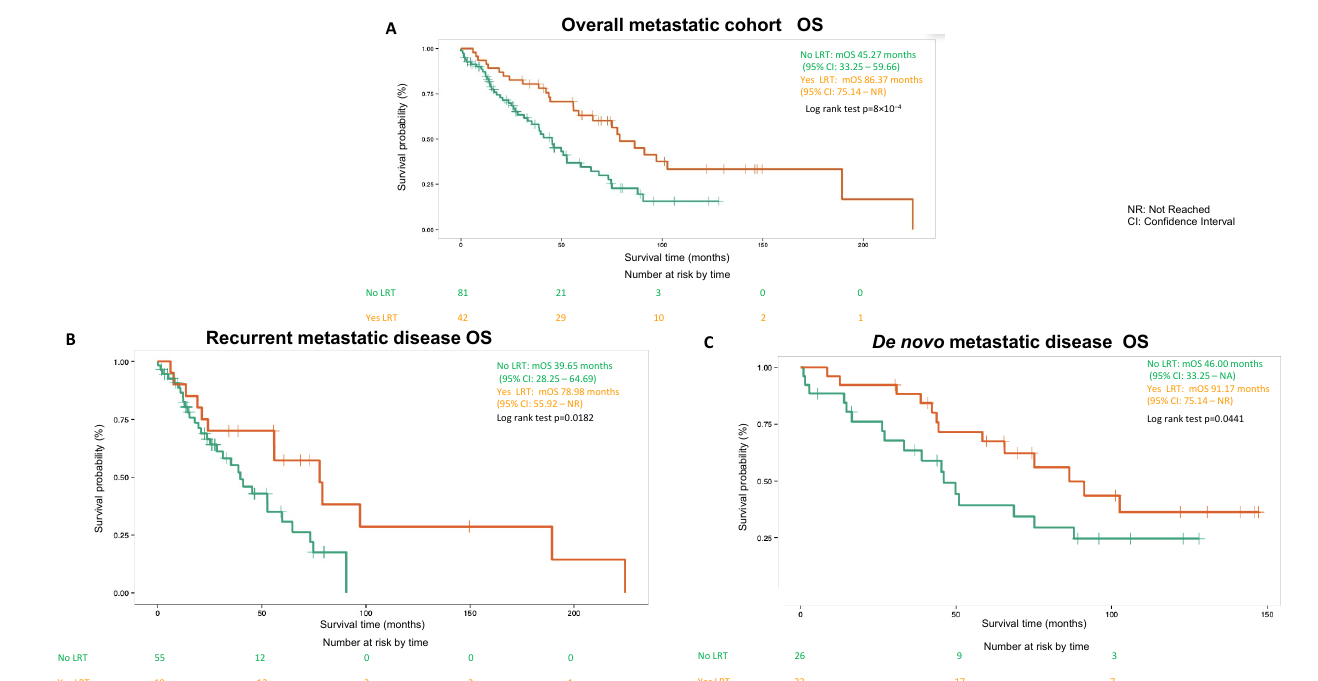
Figure 3—Clinical outcomes (OS) comparing metastatic GIST patients who underwent locoregional (LRT) versus no LRT Overall metastatic cohort OS